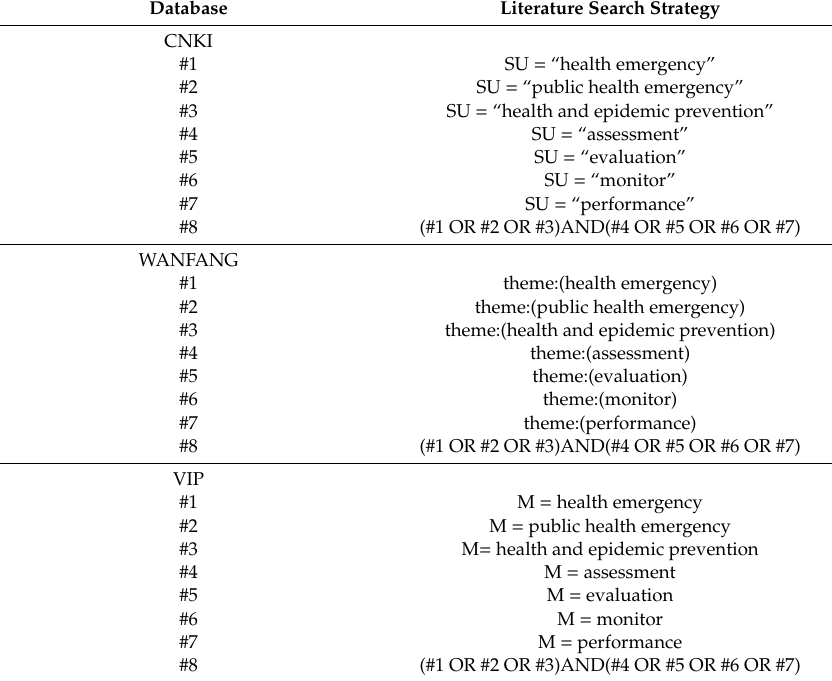
Table 1. Search terms and search